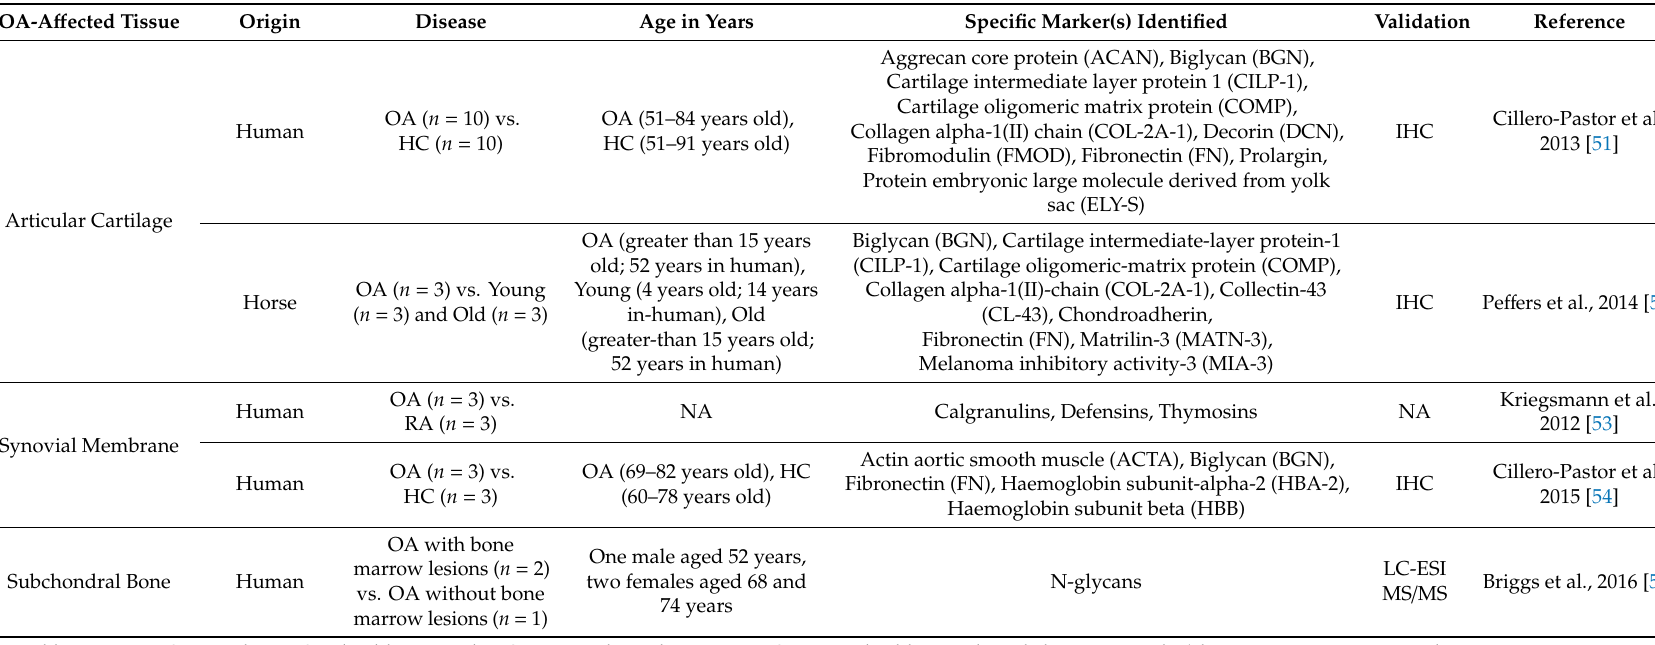
Table 2. A summary of OA-derived tissue studies using matrix-assisted laser desorption / ionisation mass spectrometry imaging (MALDI-MSI). OA-A ff ected